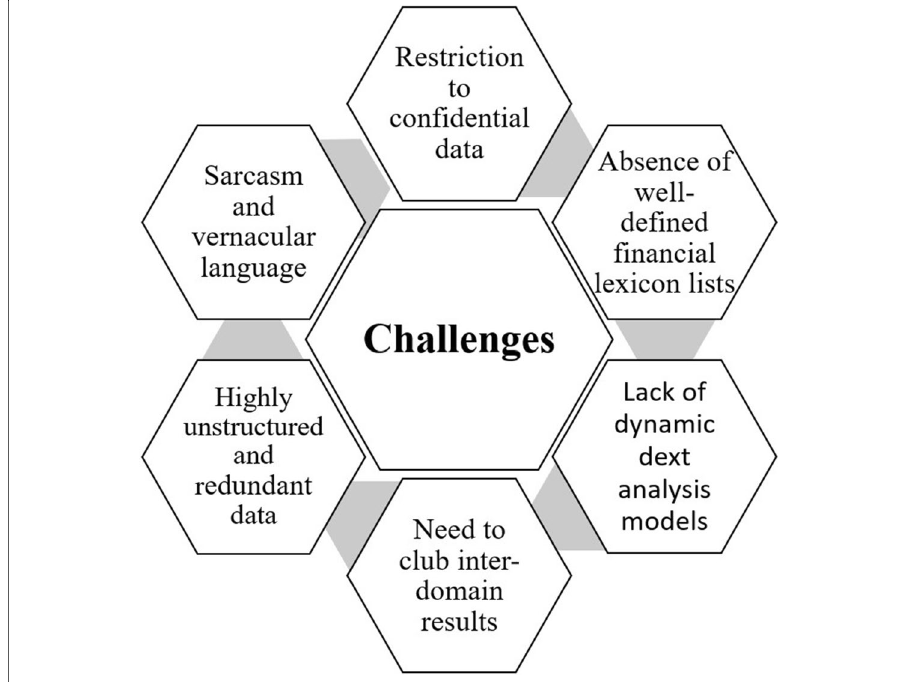
Fig. 4 Major challenges to text mining in